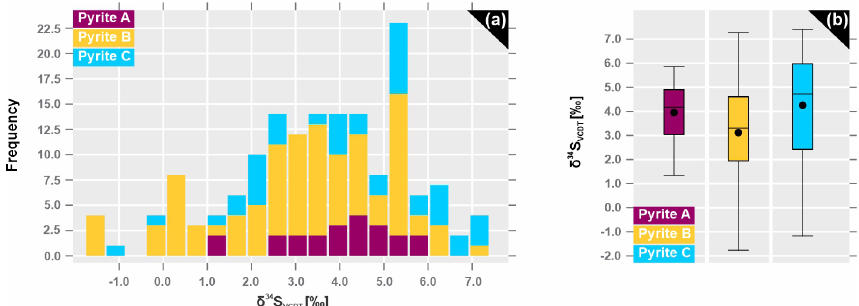
Figure 13. Frequency δ 34 S histograms for (a) analyzed pyrite. (b) Comparison of analyzed δ 34 S values from pyrite A, B and